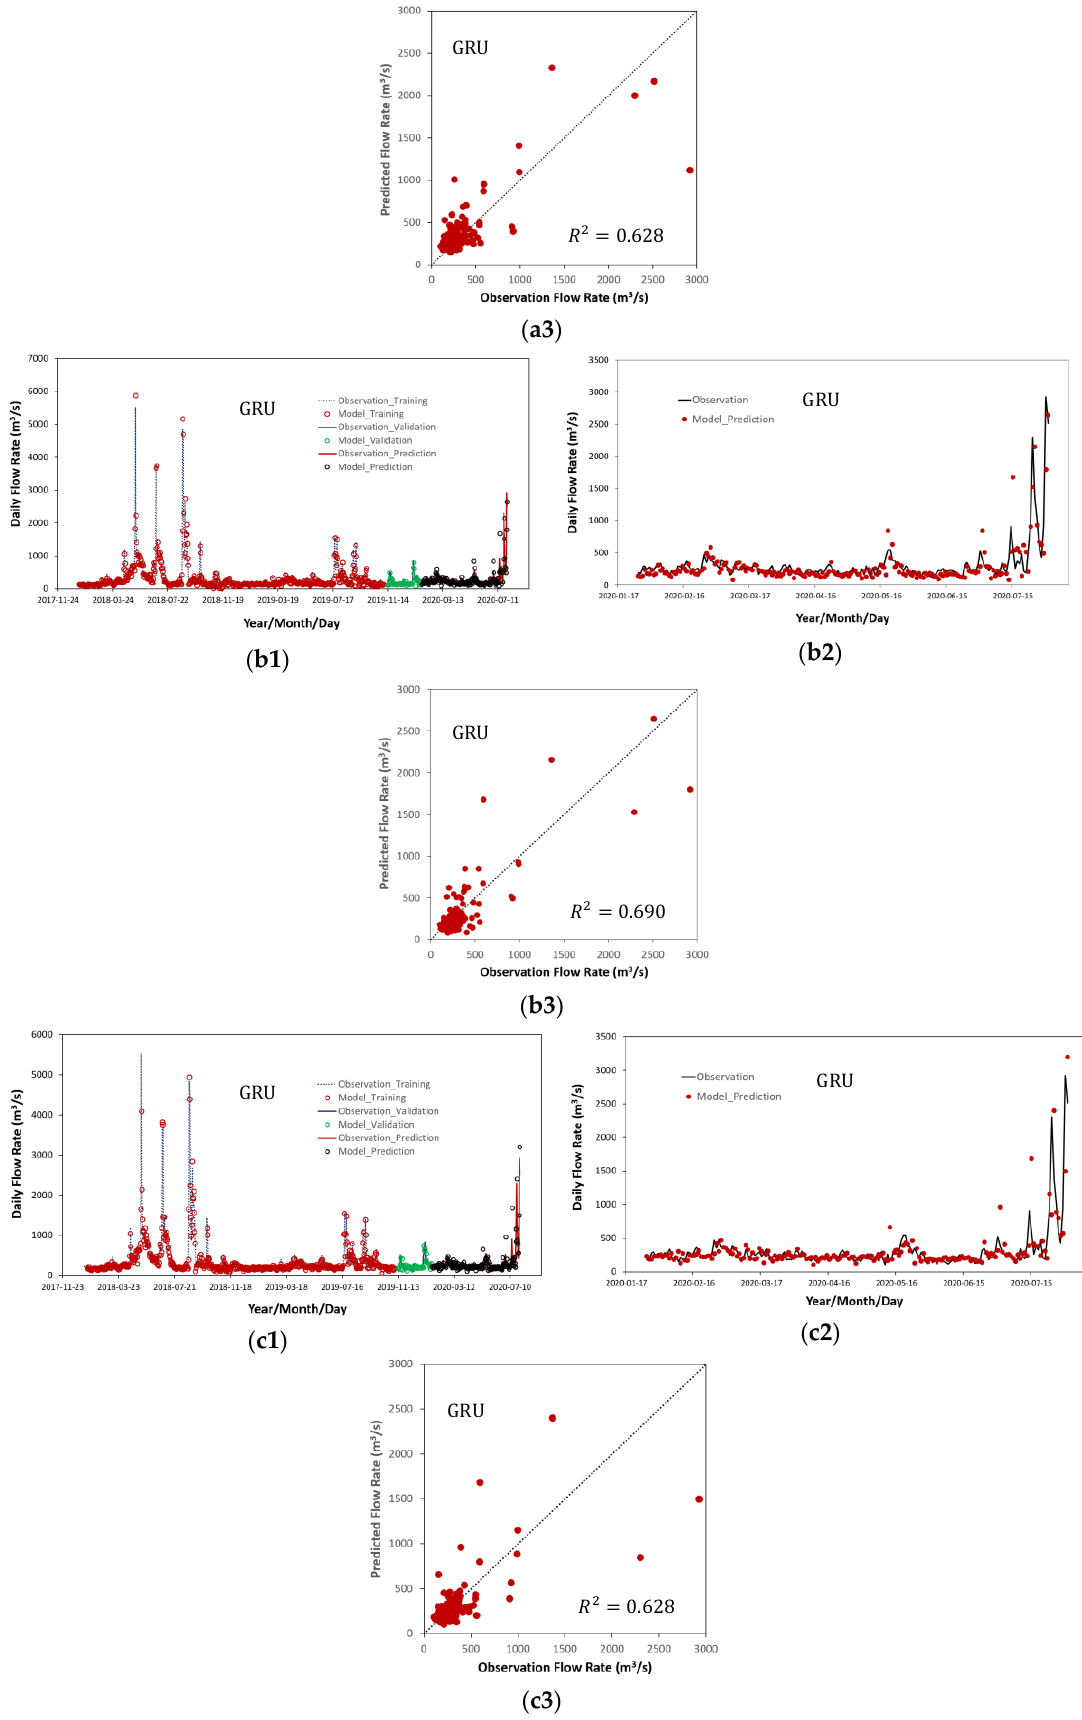
Figure 9. Observed and computed total time series flow rates ( a1 )–( c1 ), observed and